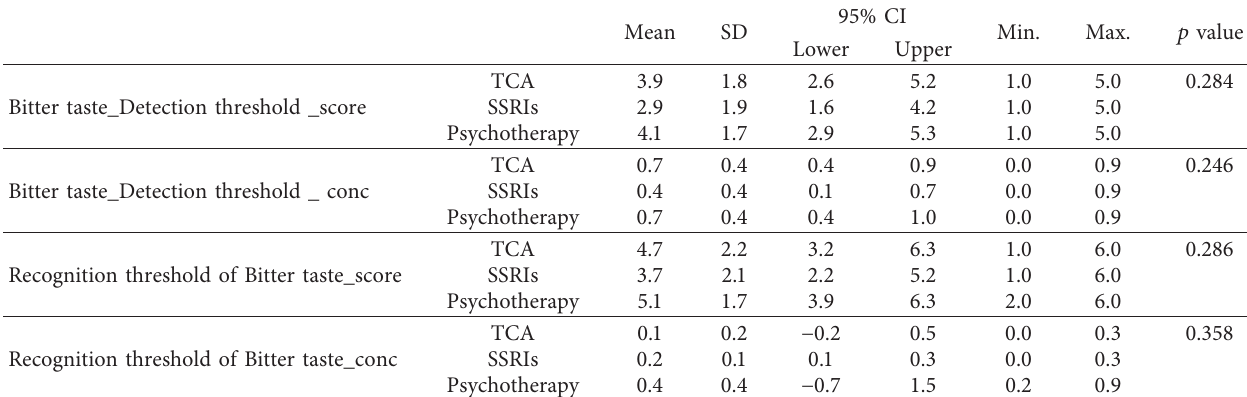
Table 5: Descriptive statistics and one-way ANOVA for bitter detection and recognition thresholds scores and concentrations among the tested